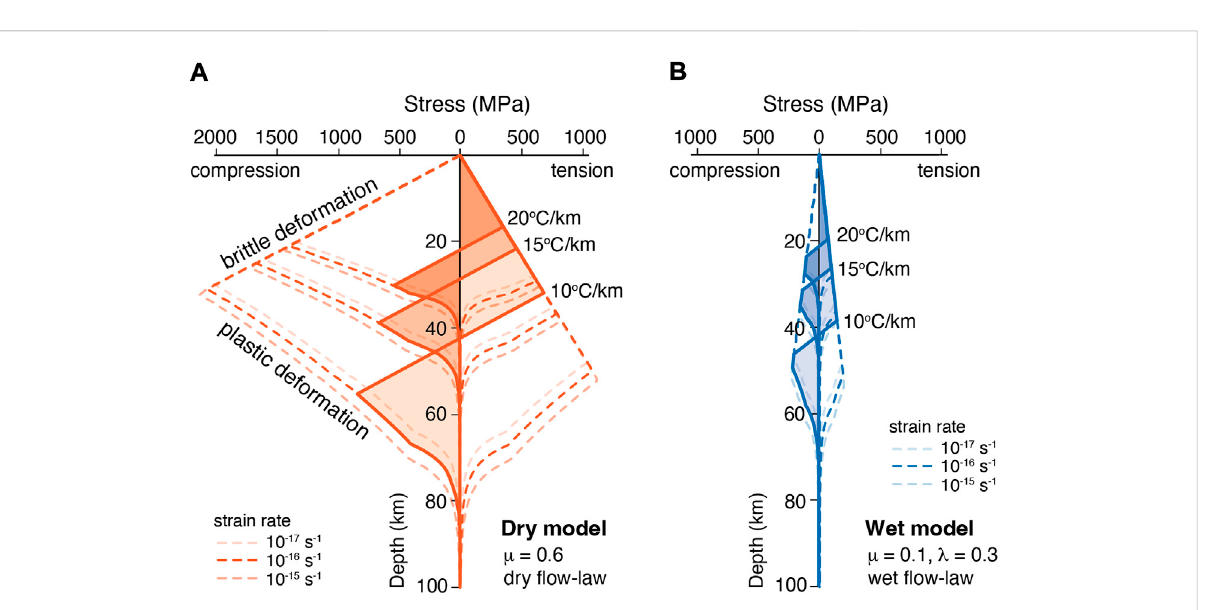
FIGURE 4 Strength pro fi les of lithosphere for dry (A) and wet (B) models. Plastic strengths for variable thermal gradients calculated using different strain rates of 10 – 15 , 10 – 16 and 10 – 17 s − 1 . A fl exural curvature of 5×10 – 7 m − 1 was assumed, and positive and negative stresses correspond to tension and compression, respectively. The bending moment was calculated via a balance between tensional and compressional forces within the fl exed lithosphere (shaded area). The depth of Moho was assumed to be 20 km, in which the crustal thickness could be thicker during Archean than that of the present-day oceanic